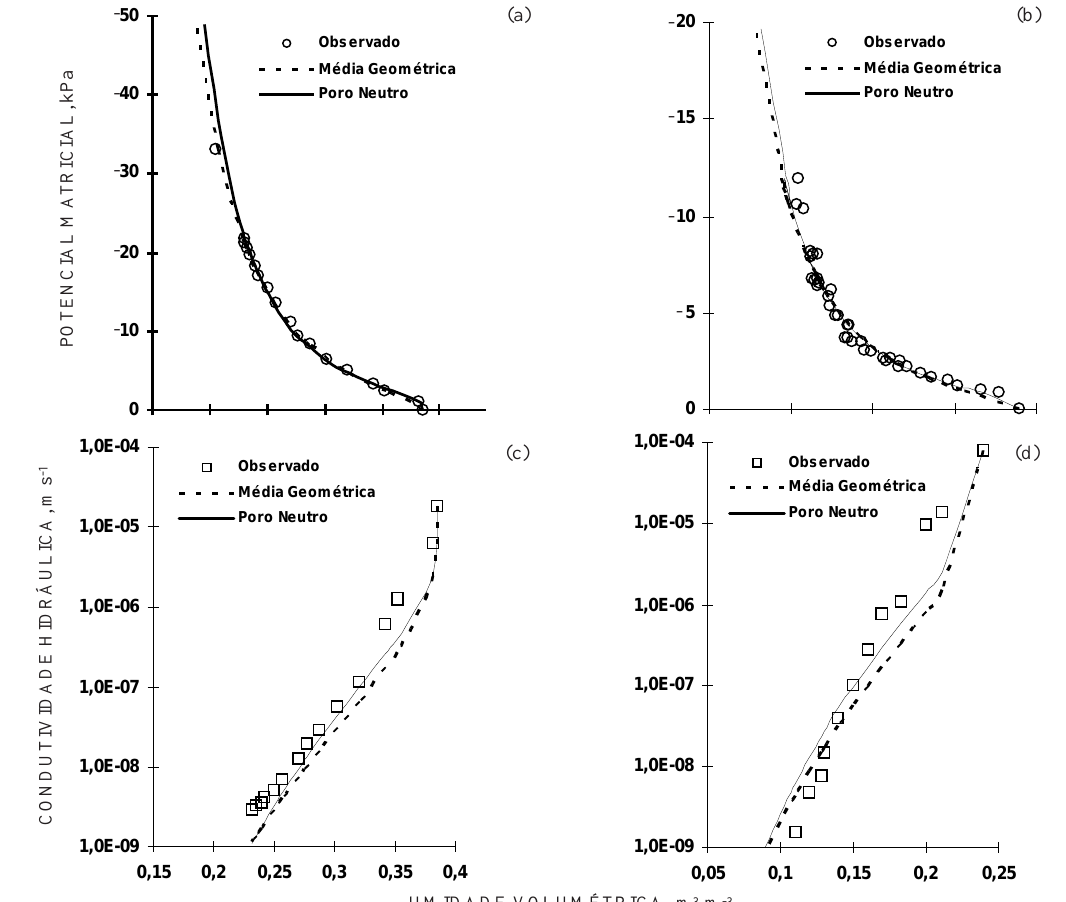
Figura 3. Curvas de retenção da água no solo observadas e ajustadas (equação 17) com a relação entre m e n obtida a partir dos modelos da Média Geométrica (equação 19) e do Poro Neutro (equação 20) para: (a) Latossolo Vermelho-Amarelo; (b) Argissolo Amarelo e curvas da condutividade hidráulica preditas pelos modelos para: (c) Latossolo Vermelho-Amarelo e (d) Argissolo Quadro 3. Resultado da análise estatística entre os valores das condutividades hidráulicas preditas pelos modelos da Média Geométrica e do Poro Neutro e os valores experimentais para o Latossolo Vermelho- Amarelo e o Argissolo Amarelo